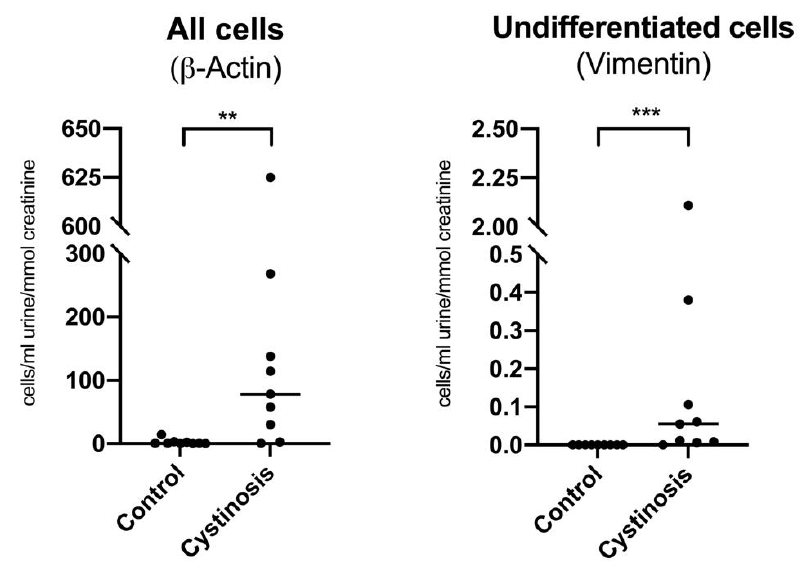
Figure 1. Quantification of undifferentiated cells in urine of cystinosis patients versus healthy controls. Total number of cells ( β -Actin signal, left) and number of undifferentiated cells (vimentin signal, right) voided in urine of cystinosis patients ( n = 9) compared to healthy controls ( n = 9). The cycle threshold (ct) value achieved in the qPCR analysis was plotted in a calibration curve for estimation of the total number of cells and the number of undifferentiated cells voided in urine, which was normalized to urine volume and urine creatinine values. Statistical significance was evaluated using Mann–Whitney U test comparing controls versus cystinosis patients; median is indicated with the horizontal line in the midst of the individual values. p < 0.01: **; p < 0.001: